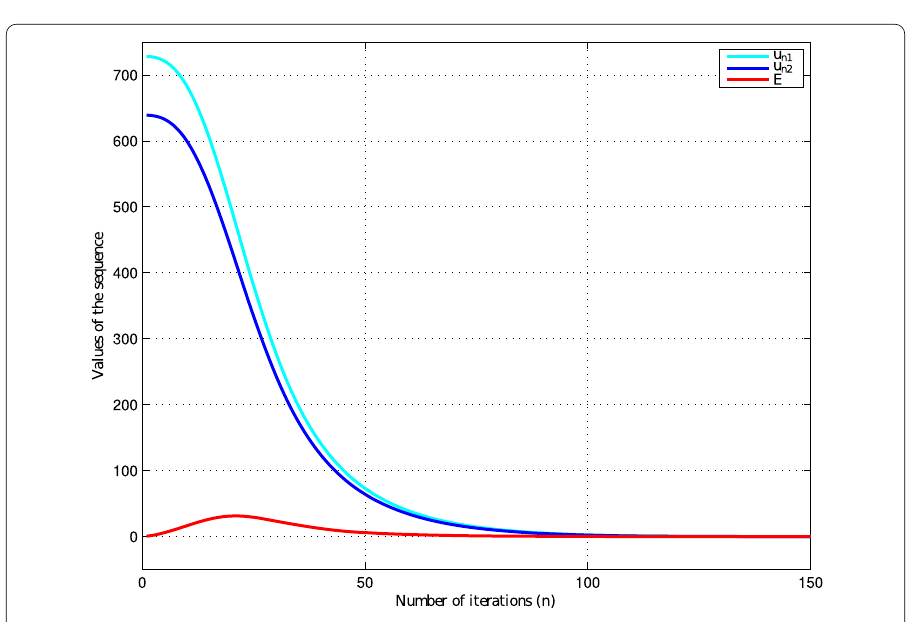
Figure 4 Convergence result of Theorem 3.5 with starting point of Case